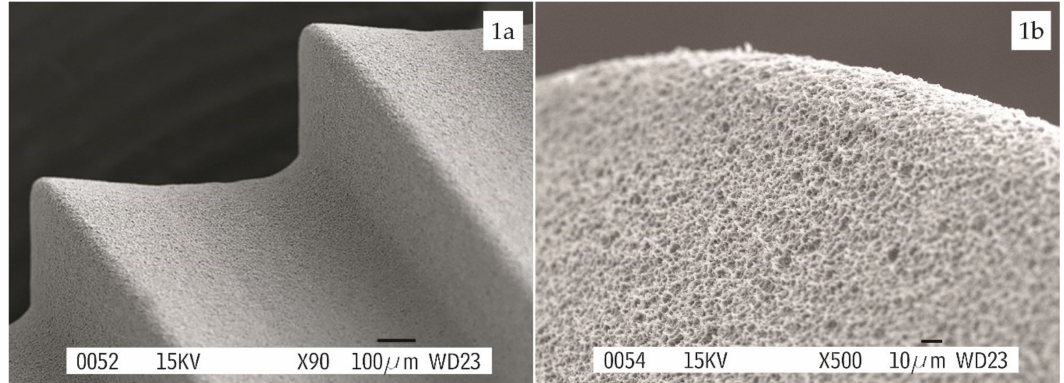
Figure 1. SEM images provided by the manufacturer of the double acid-etched surface topography (TSA Defcon ® screw implants, Impladent, Sentmenat, Spain), ( a ) threads macrodesign detail at a magnification of × 90; ( b ) detail of surface on the thread edge at a magnification of ×